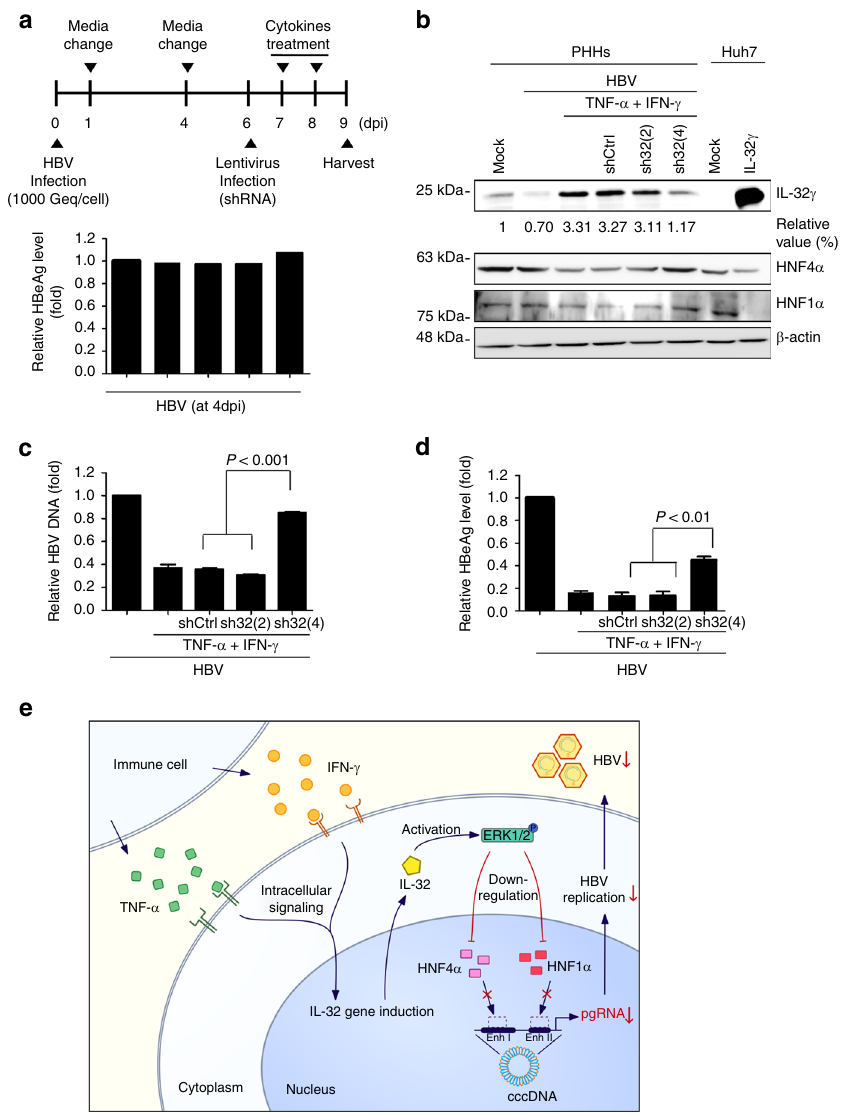
Fig. 7 IL-32 γ is involved in cytokine-mediated suppression of HBV in PHHs. a The experimental scheme. PHHs were infected with 1000 genome equivalents HBV per cell. At 4 days post-infection (dpi), the HBeAg level was determined by ELISA. b Effect of IL-32 knockdown on cytokine-induced downregulation of HNF1 α and HNF4 α . PHHs were infected with HBV and shIL-32 lentivirus as described in a . Cytokines were added for 2 days before harvest. c , d Effect of IL-32 knockdown on cytokine-induced inhibition of HBV replication and HBeAg secretion. Aliquots of cell lysates were used for real- time PCR and HBeAg ELISA. e A hypothetical model of IL-32 γ -mediated suppression of HBV through downregulation of HNF1 α and HNF4 α expression. When hepatocytes are infected with HBV, immune cells secrete TNF- α and IFN- γ , which induce the expression of IL-32 γ . IL-32 γ activates ERK1/2, which in turn downregulates the expression of HNF1 α and HNF4 α . Finally, the binding of HNFs to the viral enhancers/core promoter is reduced, which consequently inhibits HBV transcription and replication. Data ( c , d ) were obtained from three independent experiments (mean ± S.D.). p < 0.001 by Student ’ s t